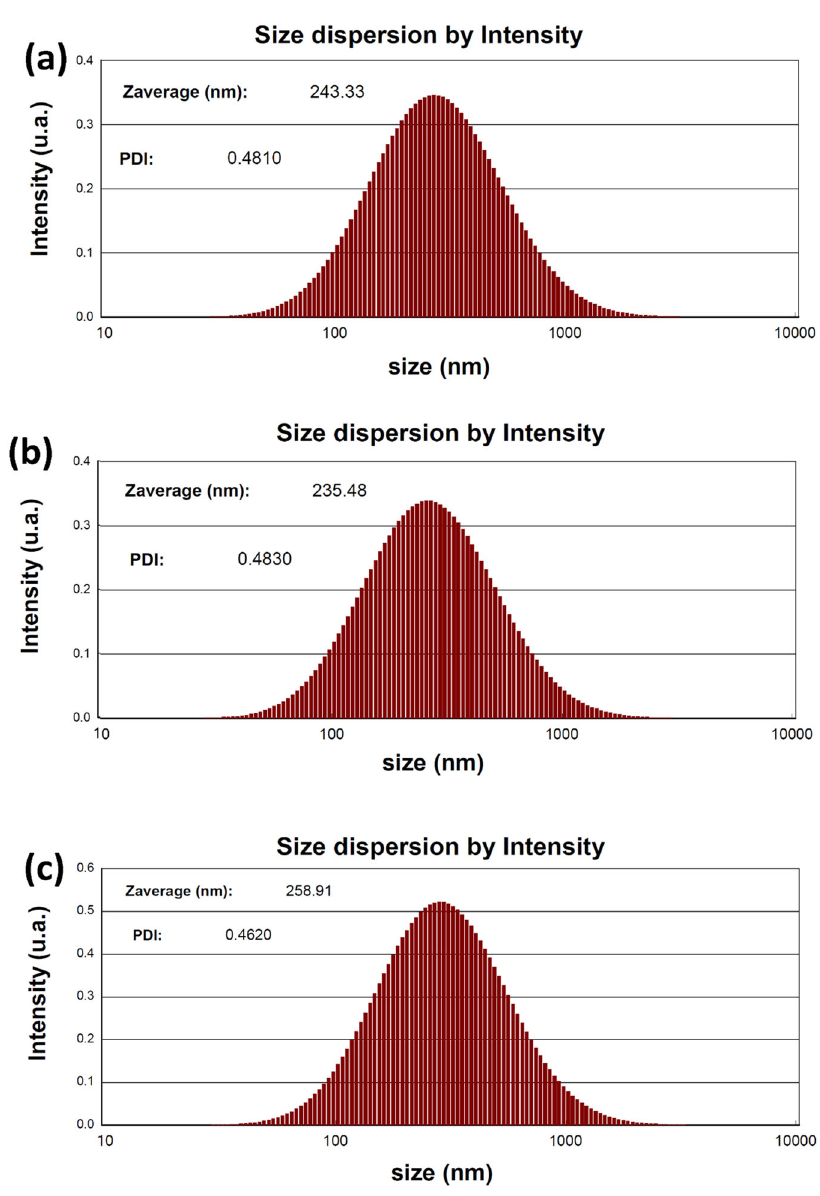
Fig. 5 DLS distribution in water and growth medium of UiO-66-